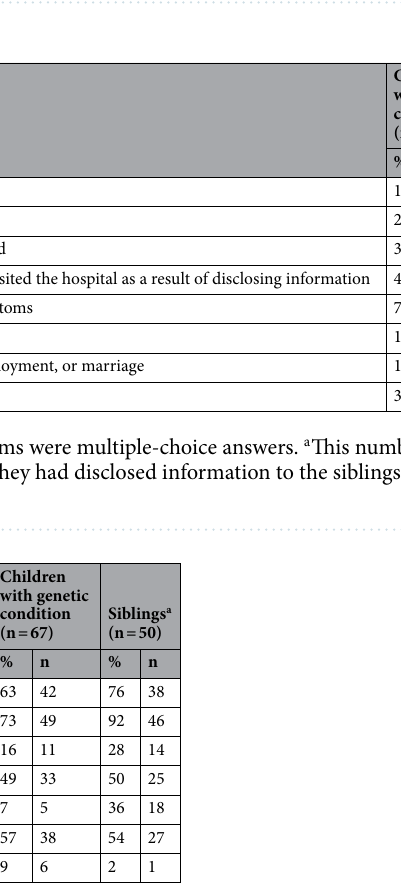
Figure 2. Age at time of disclosure. Note the number of the siblings of affected children reflects the total number of respondents who answered that they had disclosed information to the siblings of affected children both in questionnaire I (for respondents who had disclosed information to affected children) and in questionnaire II (for those who had not).